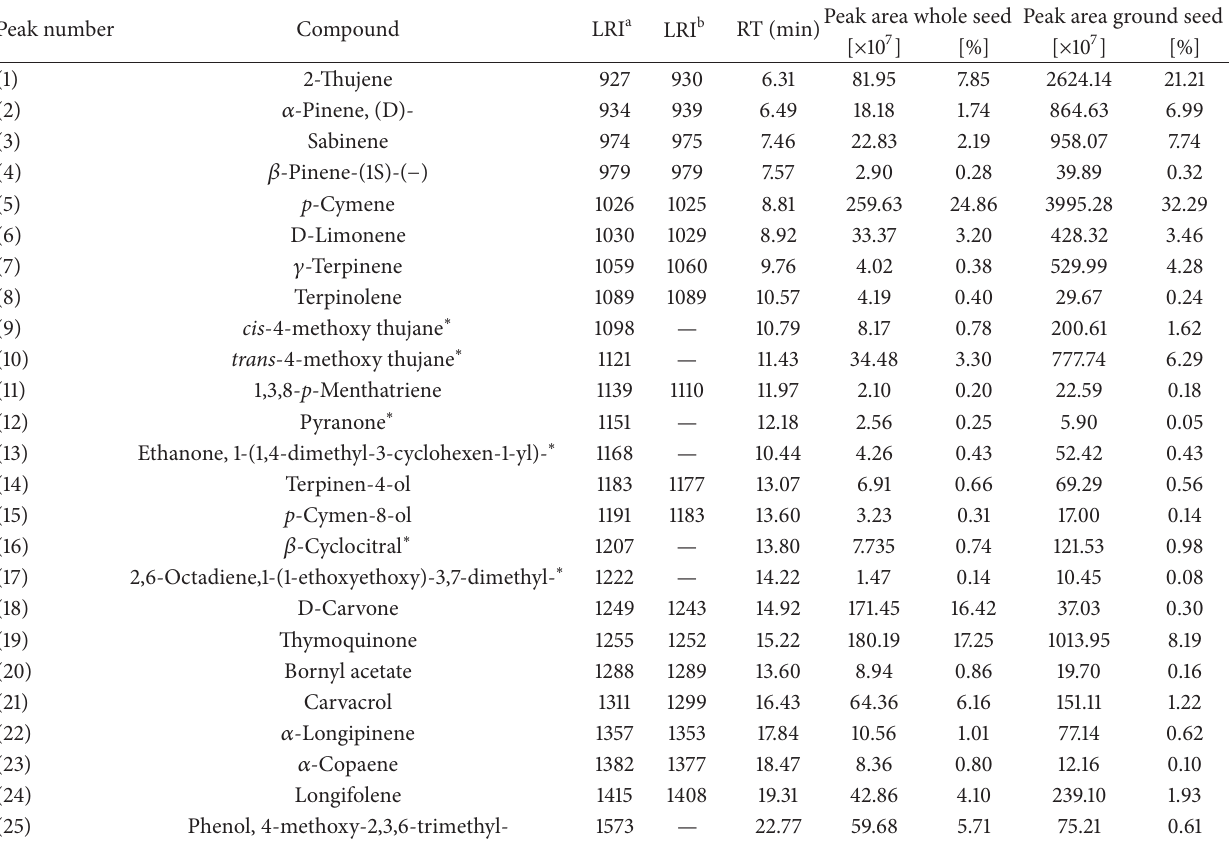
Table 1: Volatile compounds detected in N. sativa whole and ground seeds by HS-GC/MS analysis. Peak